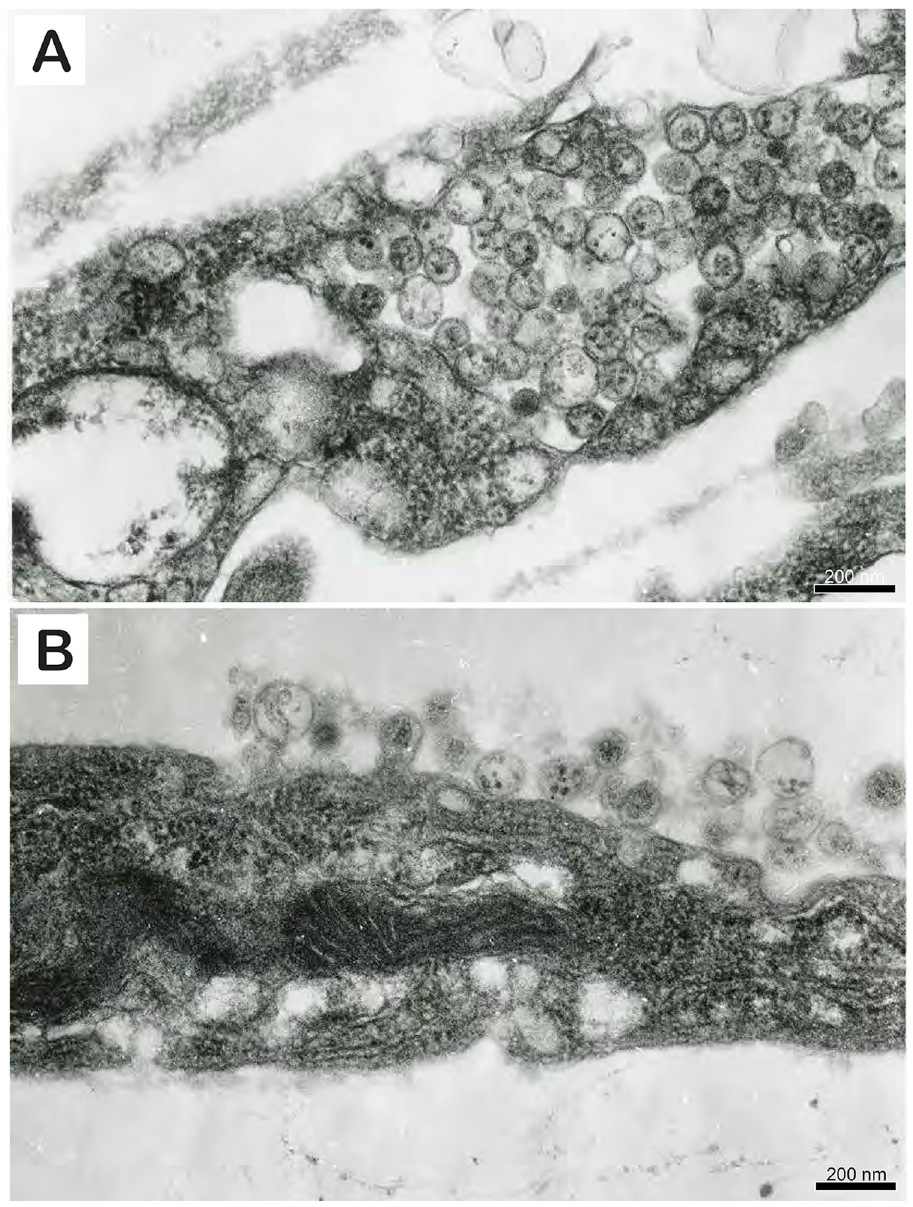
Fig 8. Thin section electron photomicrograph illustrating: A) a cluster of round to oval virus particles present in a cytoplasmic vesicle of an infected Terrapene heart (TH-1) cell. B) Turtle fraservirus 1 particles budding from the surface of an infected TH-1 cell and the presence of extracellular pleomorphic